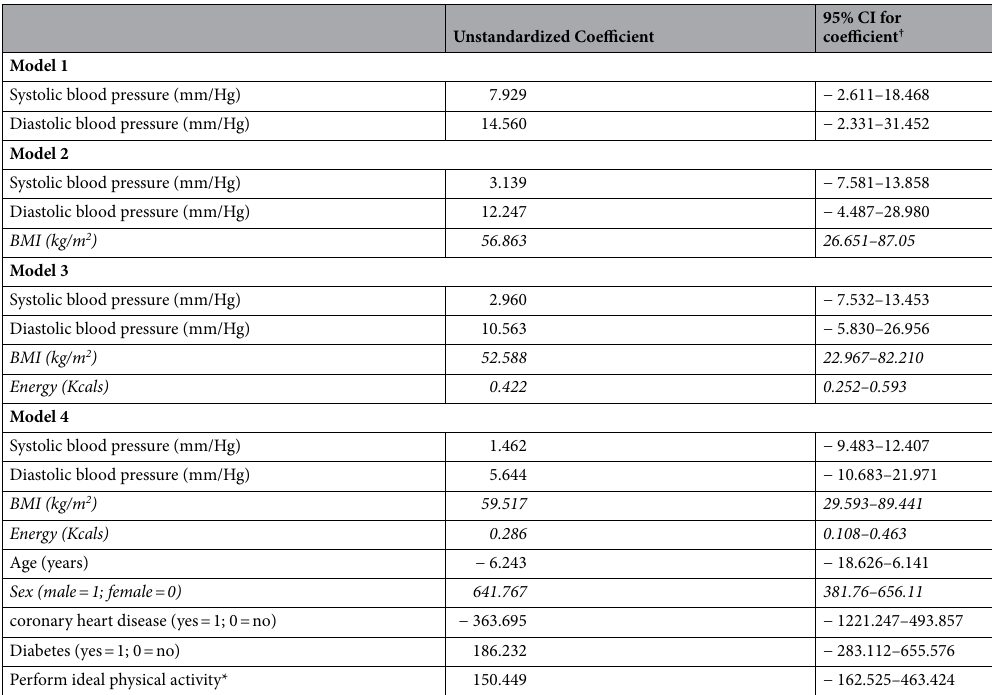
Table 3. Prediction of sodium excretion by blood pressure levels (systolic and diastolic), BMI and energy intake adjusted for other explanatory variables: a multivariate linear regression. Multivariable linear regression model with sodium excretion (mg/day) as a dependent variable and multiple variables as covariates using Enter method with 4 blocks: first block included blood pressure; second block included BMI; third block included energy intake and fourth block including age, sex, coronary heart disease, diabetes and physical activity. The unstandardized coefficient represents the amount of change in sodium excretion (in mg/day) due to a change of 1 unit of covariate. For example, independent from all other covariates in the model, for every 1 additional Kcal sodium excretion was increased by 0.286 mg/day. *As recommended by the American College of Sports Medicine (ACSM)-150 weekly minutes or more of moderate intensity or 75 weekly minutes of intense physical activity. † Significance is indicated by CI wrriten in italics BMI Body Mass Index, CI Confidence